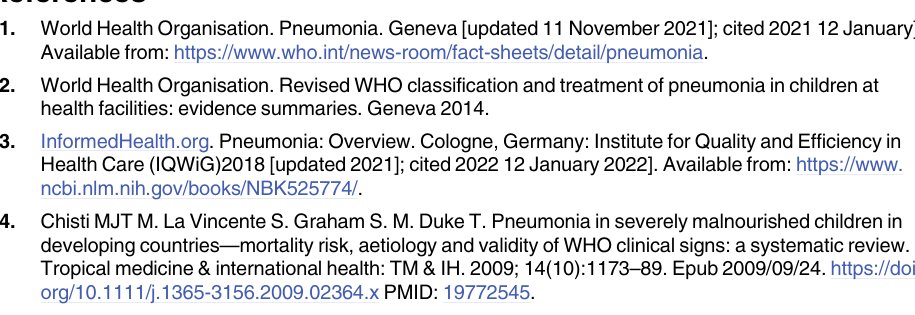
S2 Fig. Density plot of original model (children with low risk of poor outcomes of SCAP, red in color versus children with high risk of poor outcomes SCAP blue in color). (TIF) S1 Dataset. Full dataset for validation of risk prediction for outcomes of severe commu- nity-acquired pneumonia among under-five children in Amhara region, Northwest Ethio- pia.